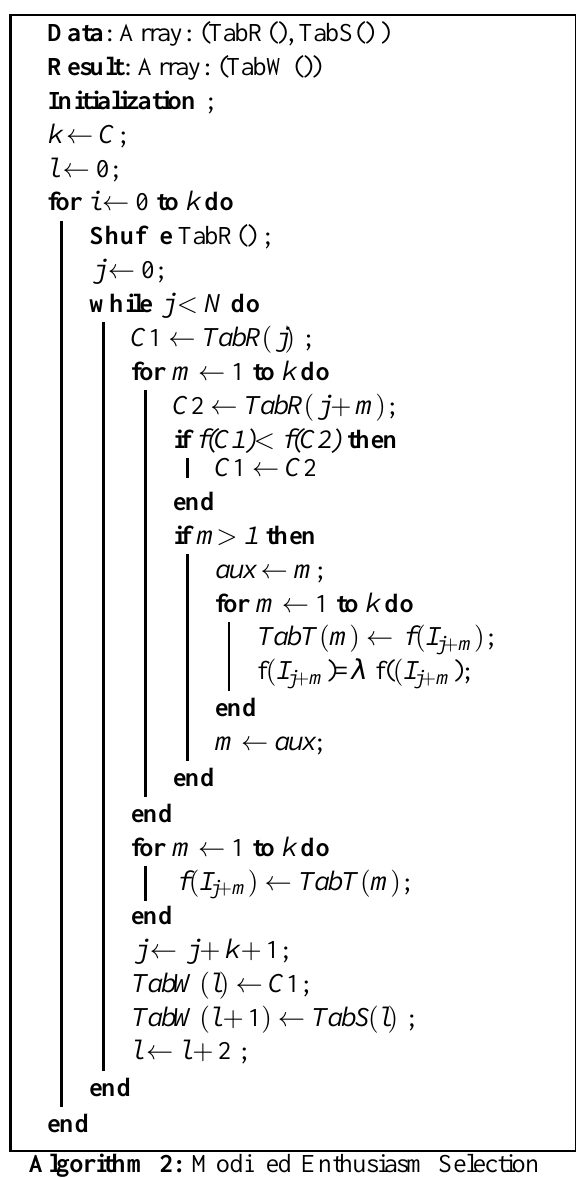
Algorithm 2: Modified Enthusiasm